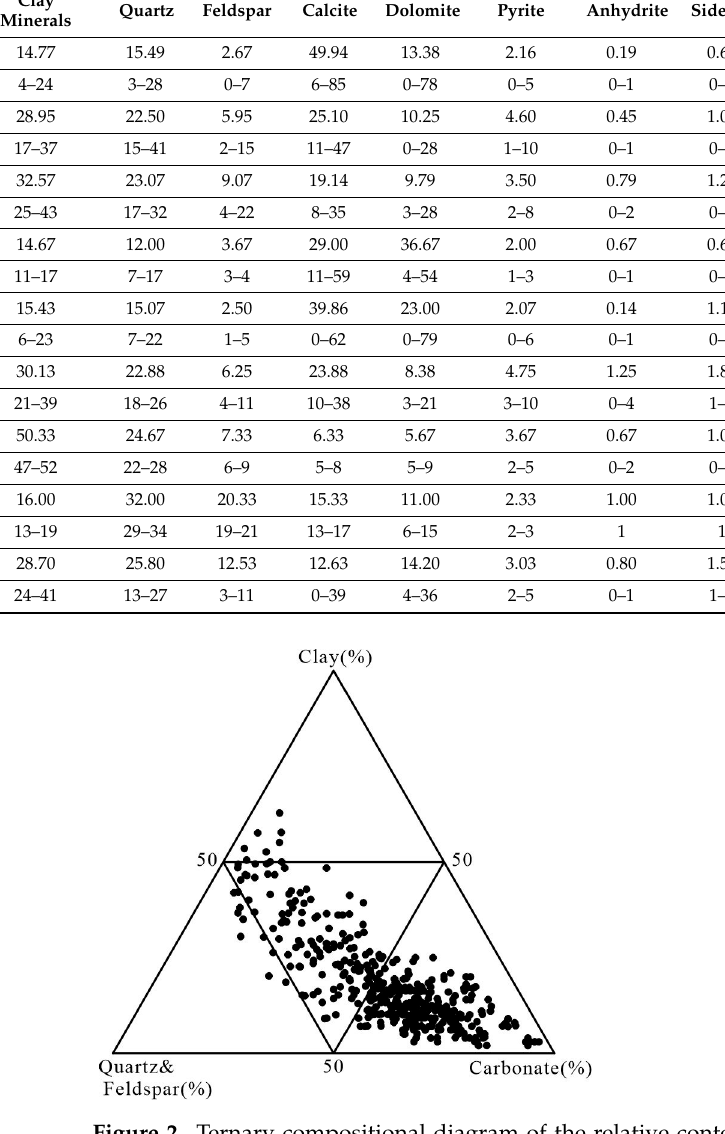
Figure 2. Ternary compositional diagram of the relative content of the carbonate minerals, clay minerals and felsic minerals of fine-grained sedimentary rocks in Es4s in Dongying Depression. 4.2.1. Middle-High Organic Laminated Calcareous Fine-Grained Sedimentary Rocks (LF1) Middle-high organic laminated calcareous fine-grained sedimentary rocks (LF1) are grayish black or dark gray (Figure 3a). The content of TOC in them ranges from 2.00 to 9.79 wt%, with an average of 3.77 wt%. They are characterized by well developed laminae and abundant carbonate minerals (average: 63.32 wt%) (Table 1) including